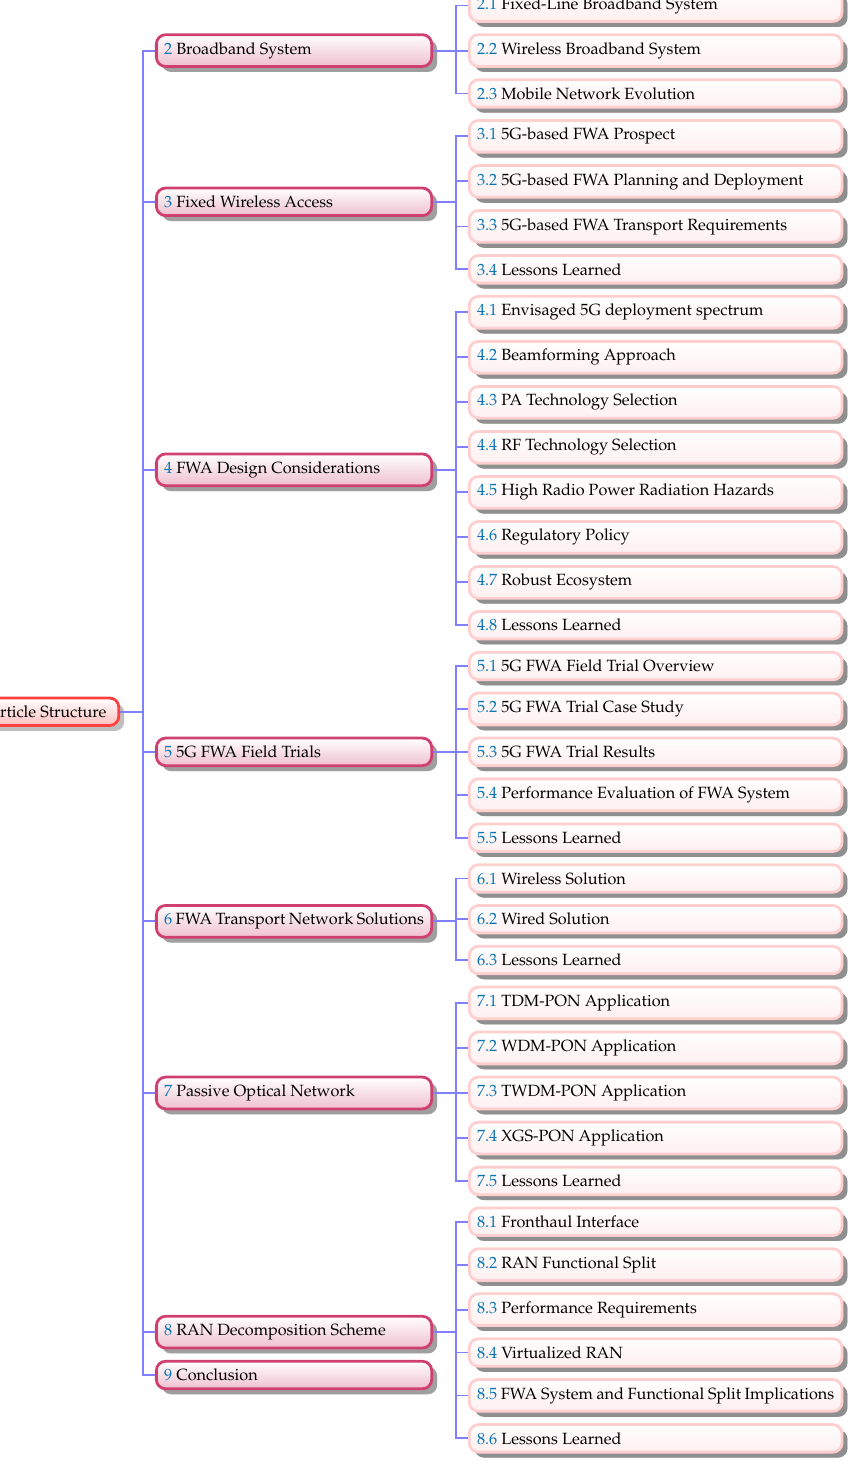
Figure 1. Schematic of the tutorial organization with related content.